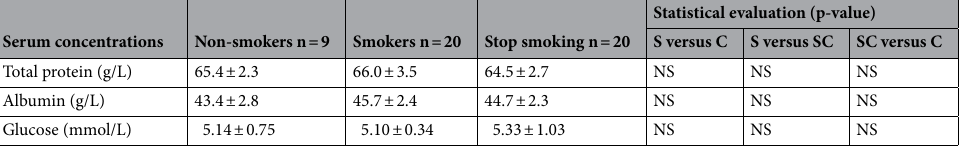
Table 2. Smoking or smoking cessation did not alter total protein, albumin and glucose serum concentration. All data are presented as mean ± SD; C: Non-smokers; S: smokers; SC: 14 days smoking cessation; NS: not significant.